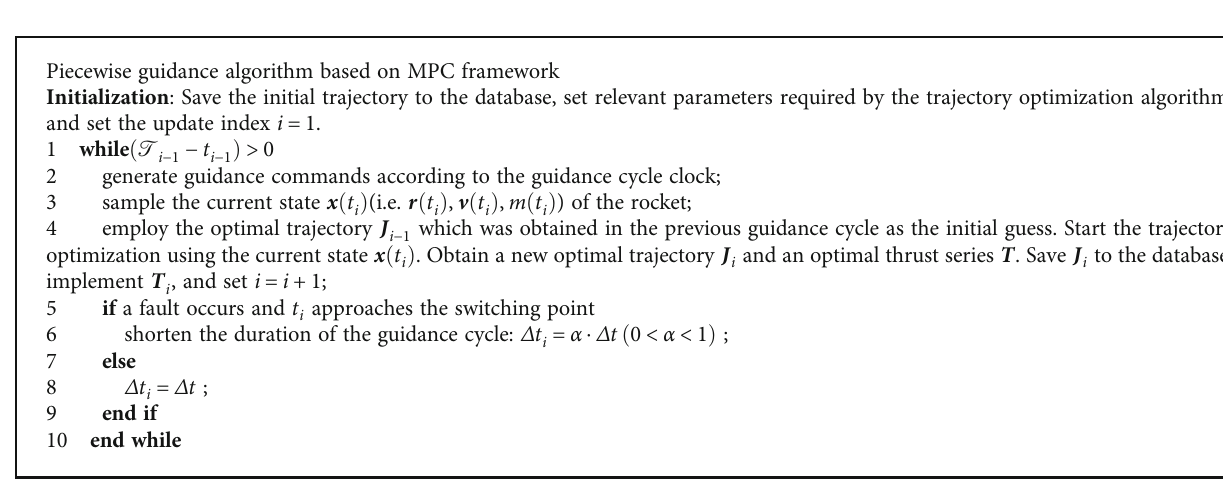
Algorithm 1: Piecewise guidance algorithm based on MPC